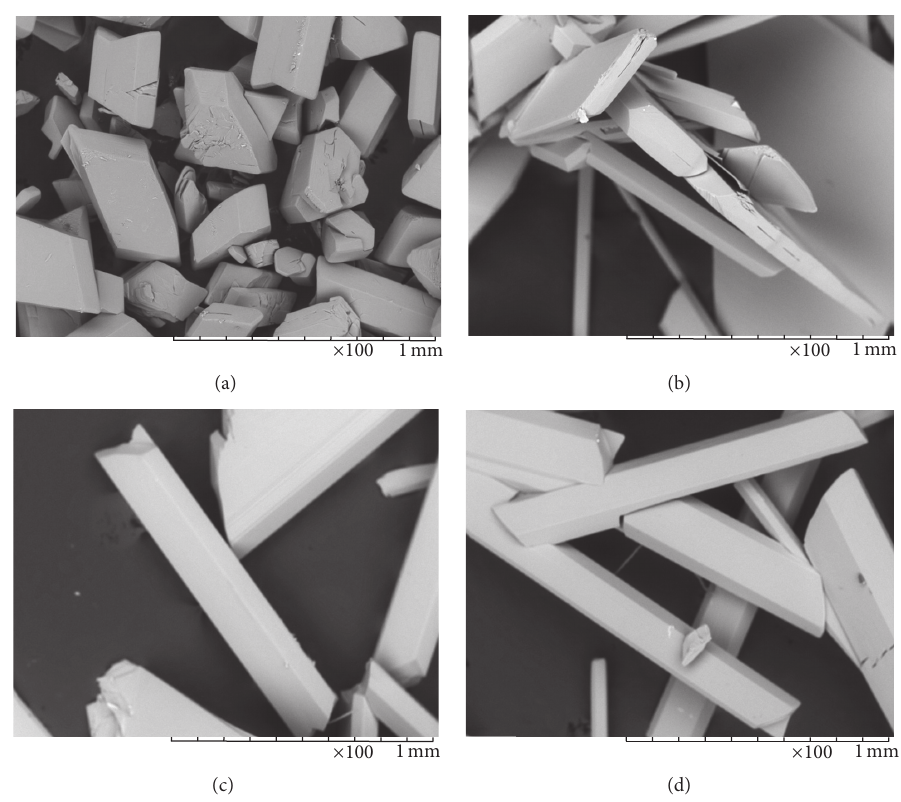
Figure 3: SEM images ( × 100) of gypsum crystals isolated in different replicate runs from the gypsum brines in the presence of 0.5 mg ⋅ dm −3